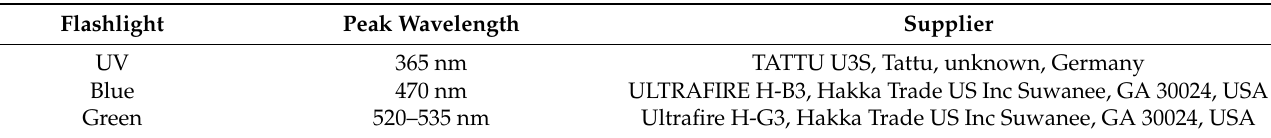
Table 2. List of flashlights used for fluorescence excitation.